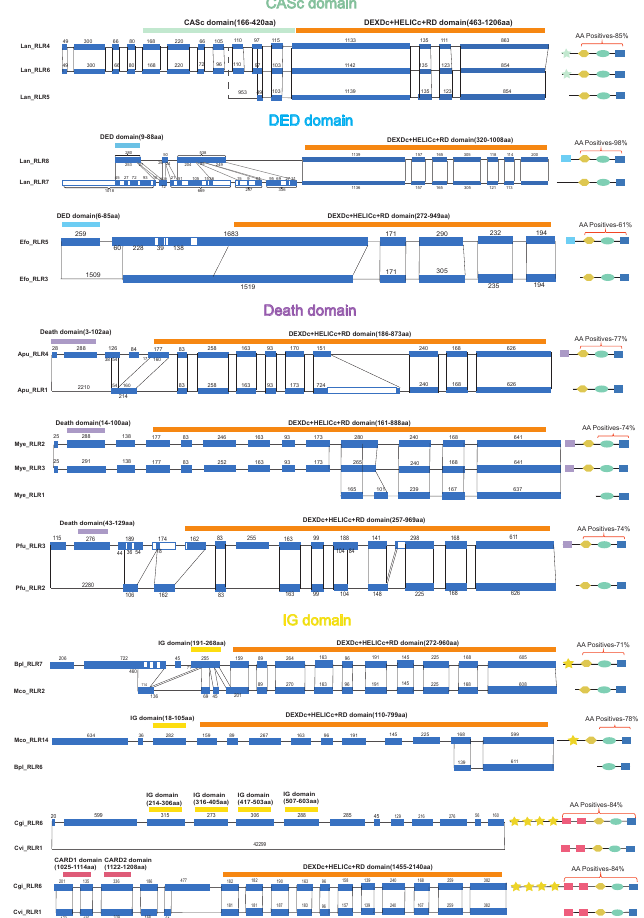
Figure 6. Exon–intron structure analysis of RLRs with diverse N-terminal domains in lophotro- chozoans. The exon–intron structures ( left ) and the schematic diagrams of the domain composition ( right ) of the RLRs with non-canonical N-terminal domains of nine groups of homologous genes. The blue rectangle represents the exon, and the solid line represents the uncoded sequence in the alignment. The number marks the length of the exon or unencoded sequence. White bars in exons depict the indels that have resulted from insertion/deletion